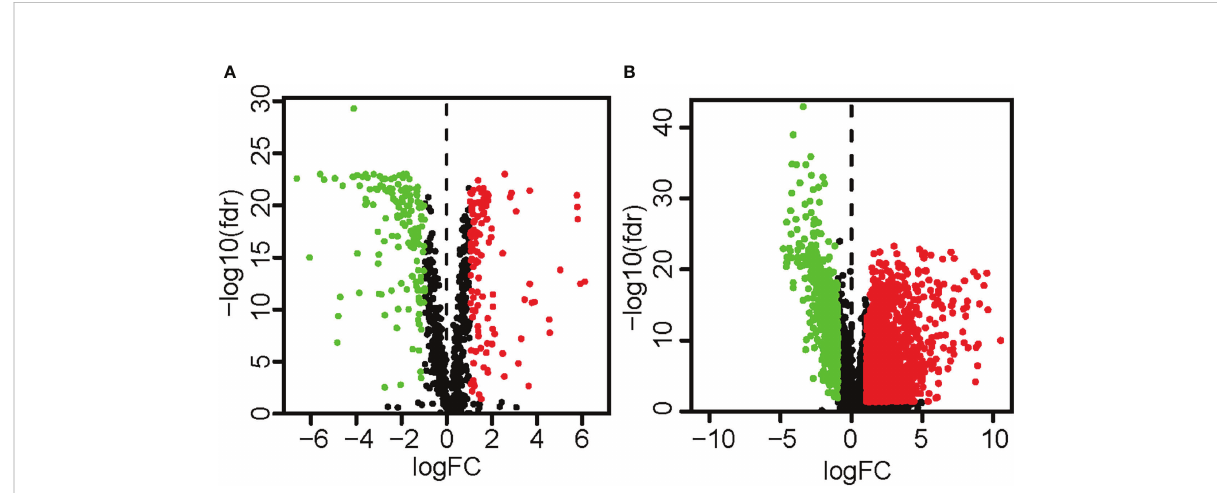
FIGURE 1 The volcano map highlighted the differentially expressed metabolism-related genes and lncRNAs in colon cancer tissues and surrounding tissues. Red showed a considerable up-regulation, green represented a signi fi cant down-regulation, and black represented no signi fi cant variation in gene expression. (A) The volcano map and heat map demonstrated the differentially expressed metabolism-related genes (| log2FC |>1, FDR< 0.05). (B) The volcano map and heat map demonstrated differentially expressed lncRNAs (| log2FC |>1, FDR<